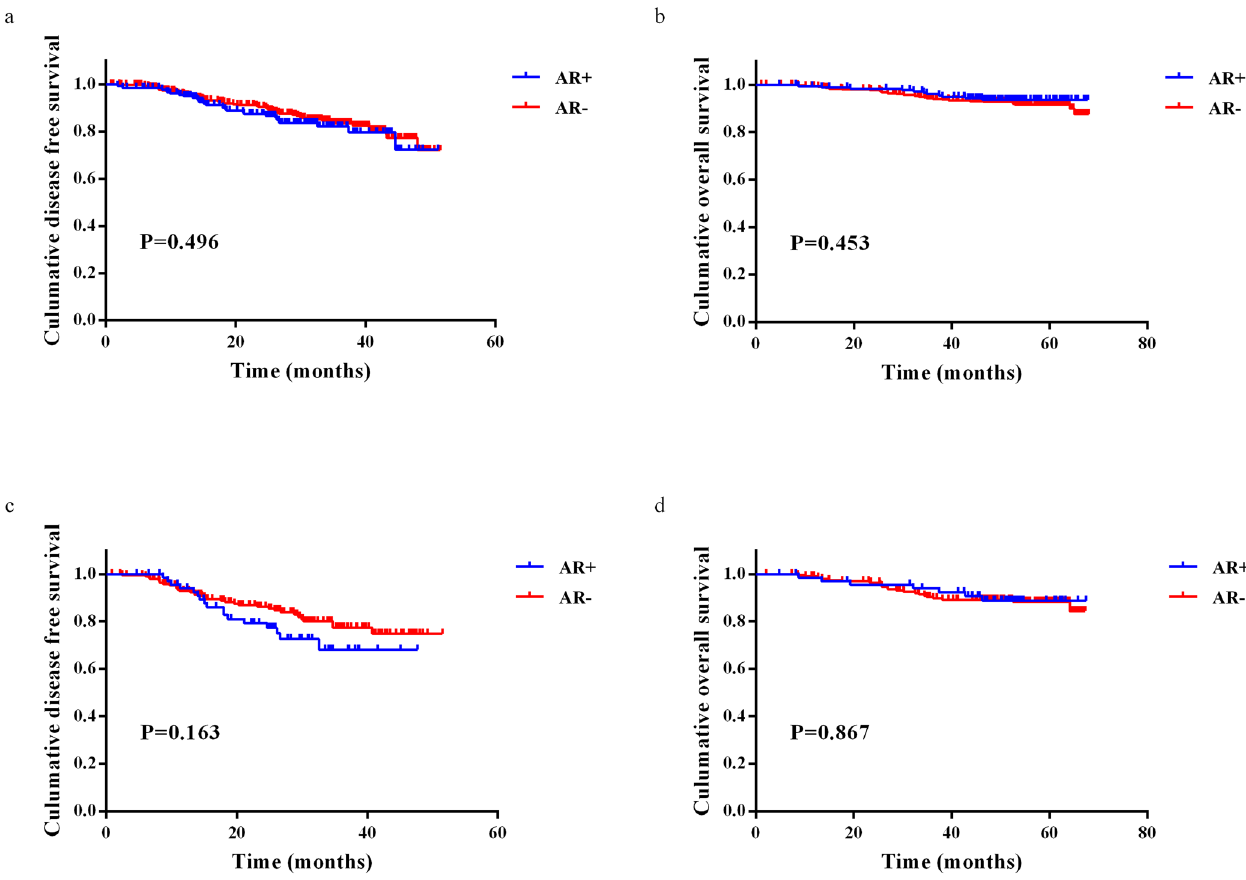
Fig. 4 Survival in patients with HER2 + nonmetastatic IDC according to AR expression (78%). a Kaplan – Meier curve for DFS of HER2 + breast cancer patients. b Kaplan – Meier curve for OS of HER2 + breast cancer patients. c Kaplan – Meier curve for DFS of HER2 + HR − breast cancer patients. d Kaplan – Meier curve for OS of HER2 + HR − breast cancer